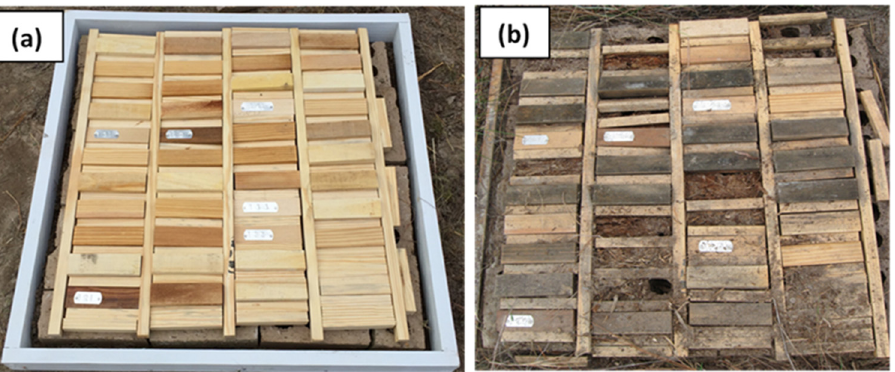
Figure 4. Example of an array in the AWPA E26 ground proximity test after installation in November 2015 ( a ) and after five years exposure, showing treated and untreated samples in poor conditions ( b ) (cover of test assembly not shown).